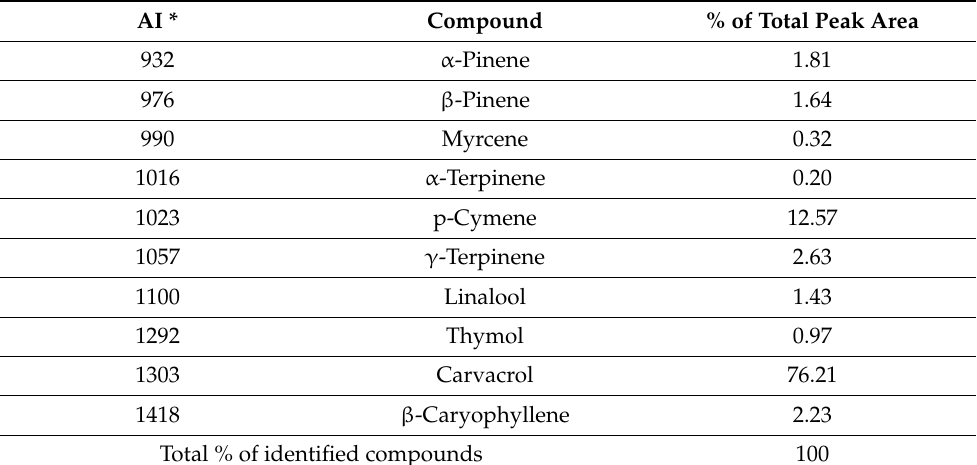
Table 1. Chemical composition (% of total peak area) of the Origanum vulgare L. essential oil de- termined by GC–MS.